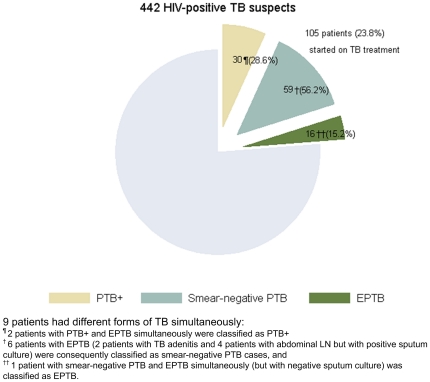
Distribution of TB categories among HIV-positive patients started on TB treatment.